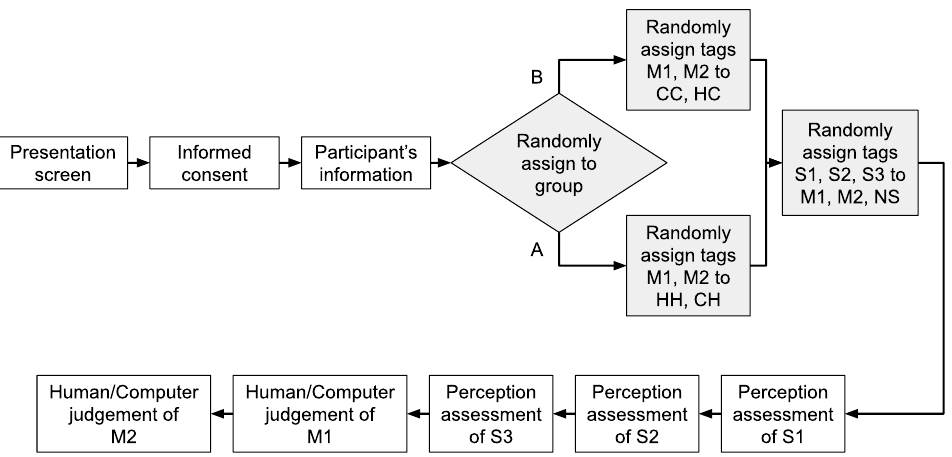
Figure 8. Test workflow. After the initial pages, the participants are randomly assigned to one group (A or B). Then, the samples are played and evaluated in a random order. Finally, the human or artificial nature of the musical pieces is assessed.